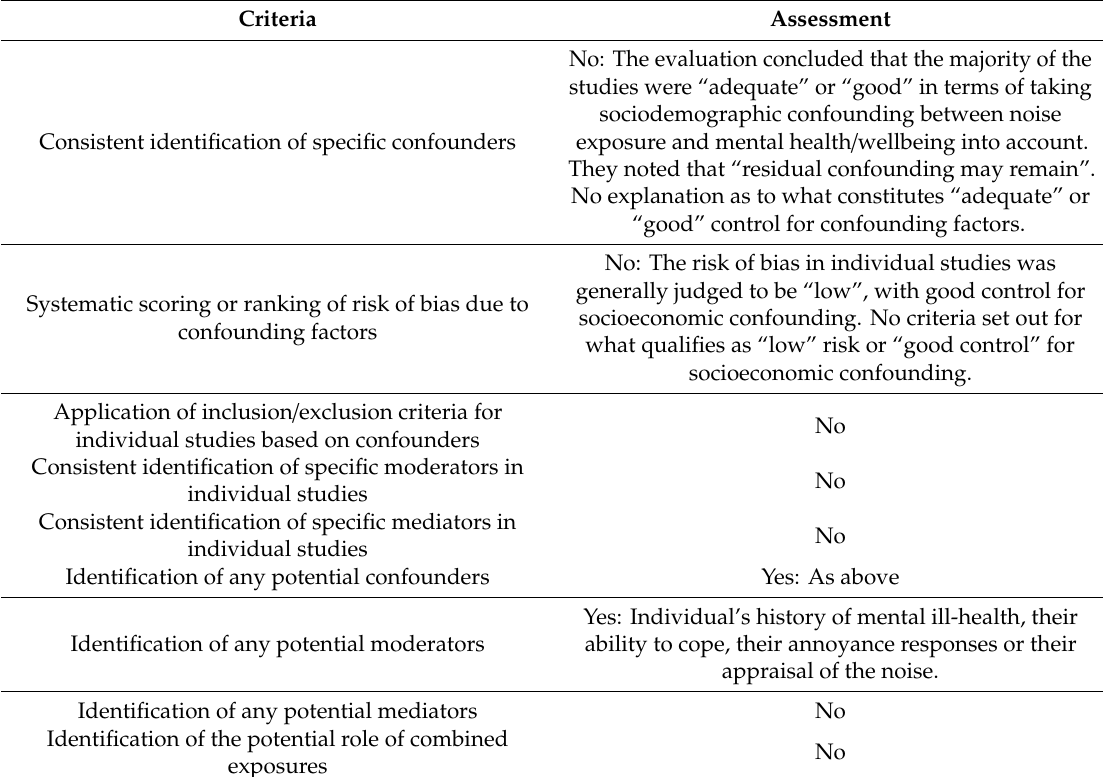
Table 6. Assessment for e ff ects on quality of life, mental health and